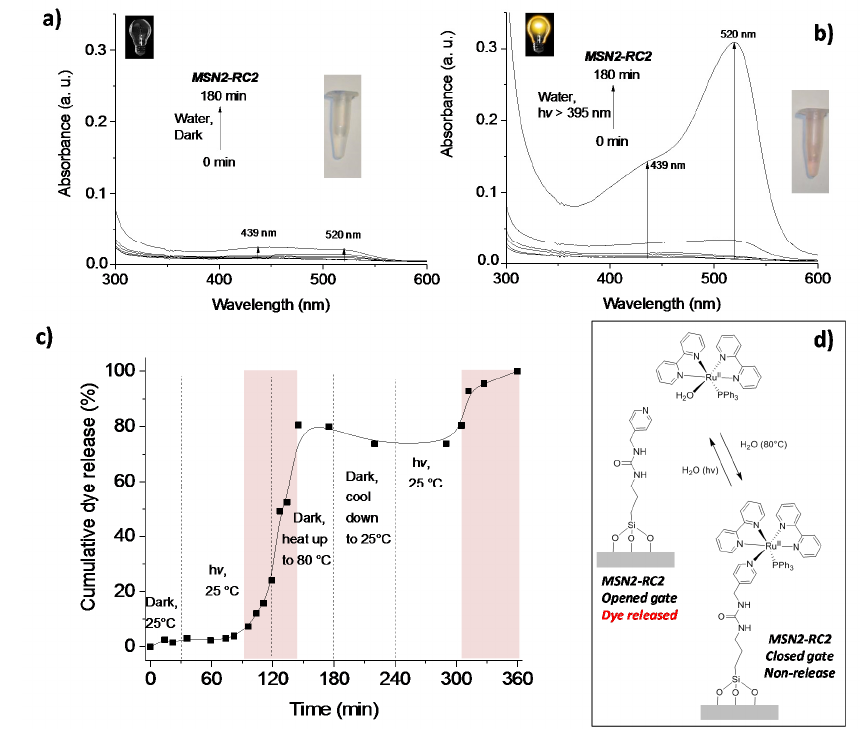
Figure 8. UV-Vis spectra of the dye solutions released from nanomaterial MSN2-RC2 under dark conditions ( a ) and after irradiation ( b ) with HBO lamp (cut-off >395 nm, in water) during 180 min; insets: Released solutions of the safranin O before ( a ) and after irradiation ( b ) for 180 min; cumulative partial release of dye (measured at 520 nm) from the nanomaterial as function of the irradiation and temperature changes ( c ) showing the reversible close–open behavior of the system and the areas marking when the release occurs; schematic drawing of the reversible photochemical cleavage of the pyridine ligand in water ( d ) releasing the dye due to opened gates after